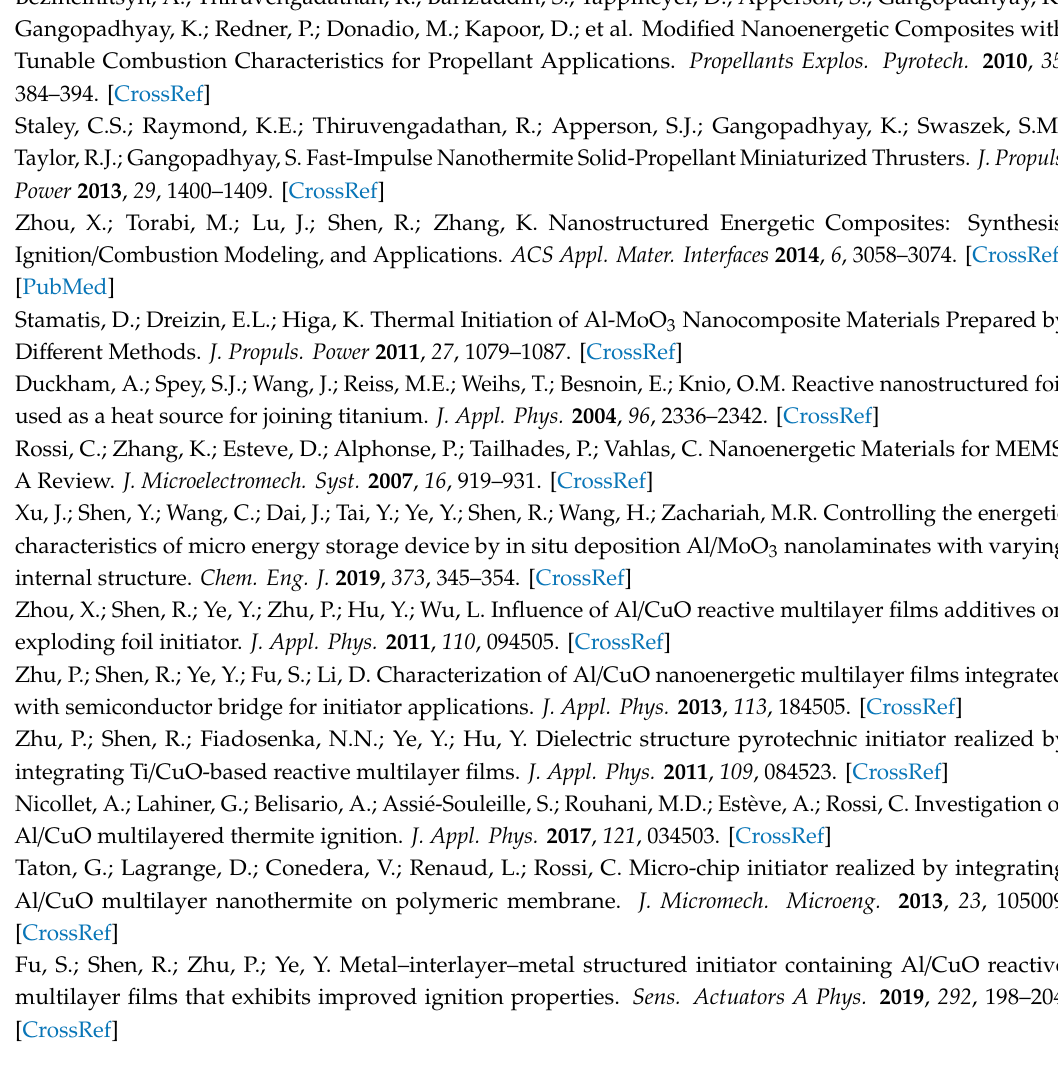
Table S1: Physical and thermodynamic parameters used in the